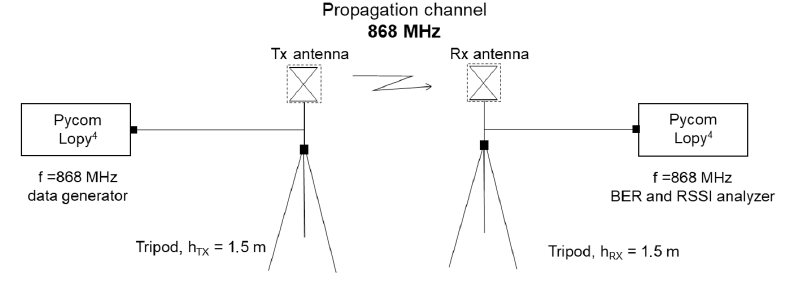
Figure 4. Measurement configuration with LoRa